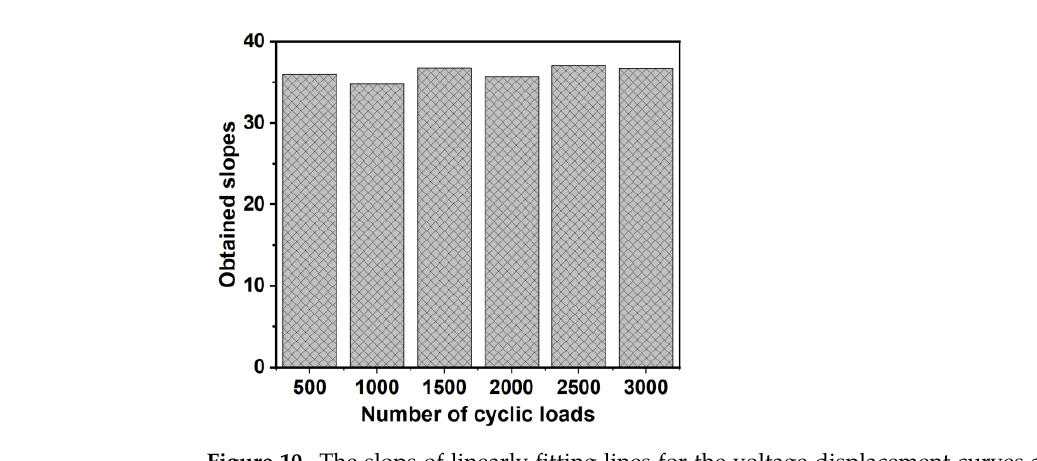
Figure 10. The slops of linearly fitting lines for the voltage-displacement curves after sustaining different numbers of cyclic loads.